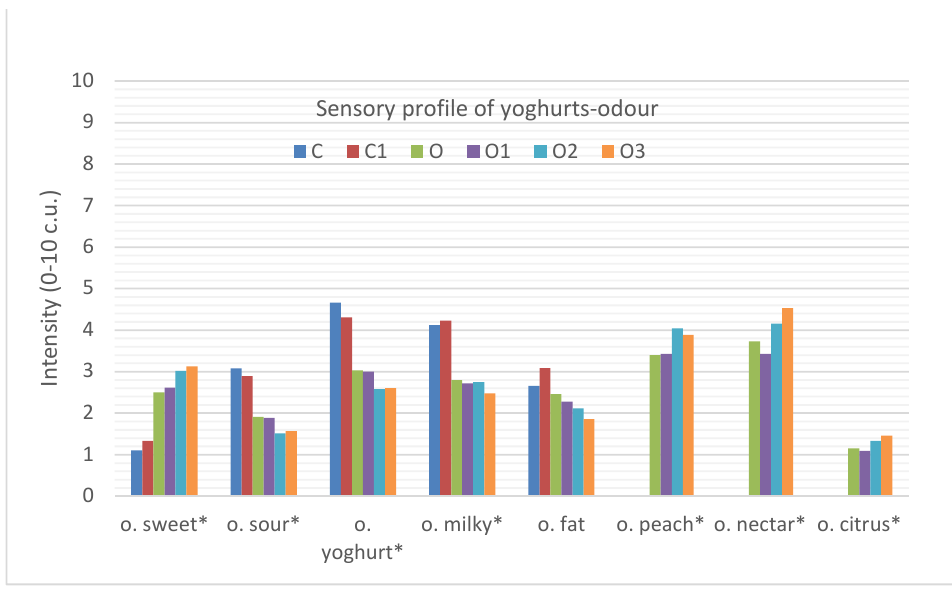
Figure 1. Sensory quality profile of yoghurts describing odour attributes. C, control; C1, control with 6% inulin; O, oolong tea; O1, oolong tea with 3% inulin; O2, oolong tea with 6% inulin; O3, oolong tea with 9% inulin (* p ≤ 0.05 differ significantly).